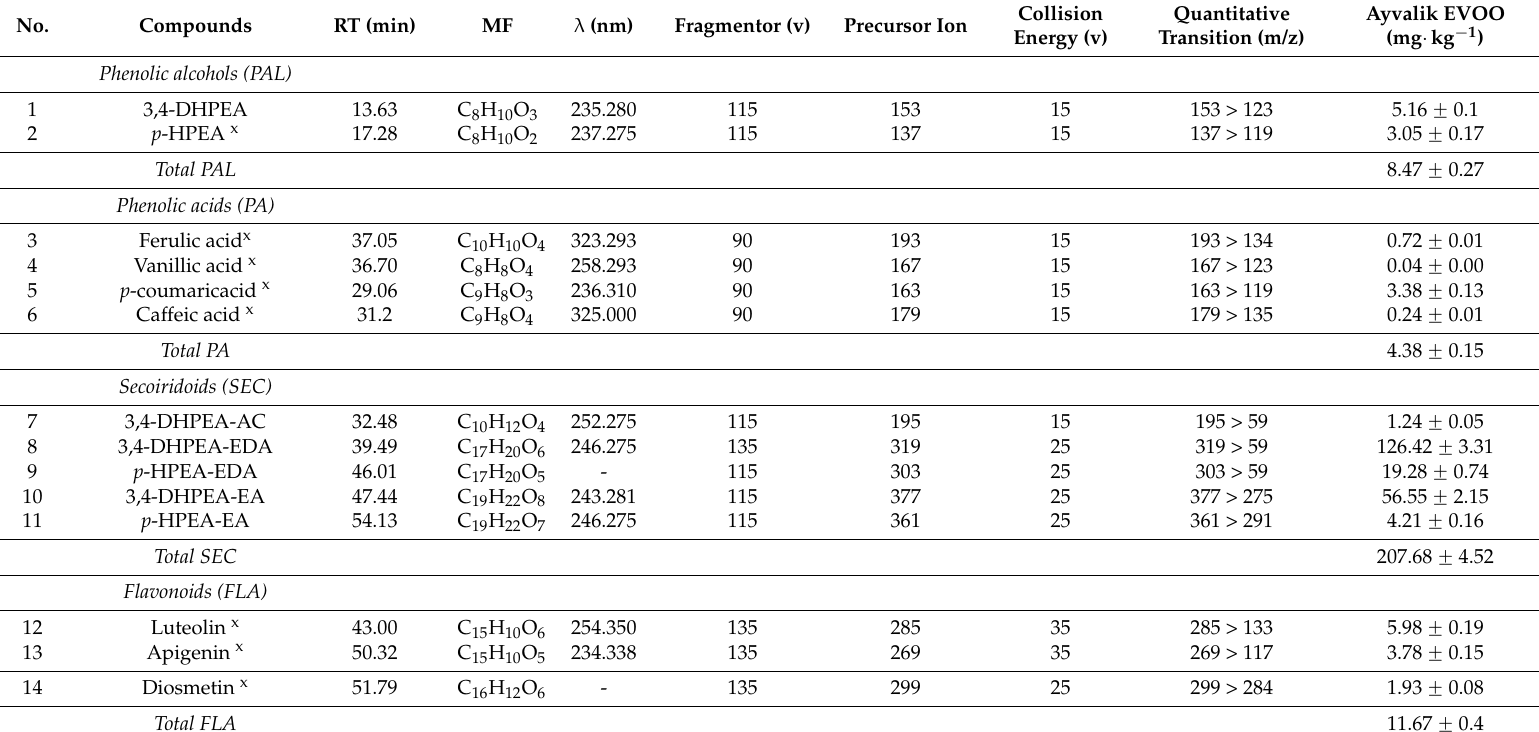
Table 4. Main phenolic compounds identified in olive oil extract by HPLC-DAD-ESI-MS/MS including: retention time (RT), molecular formula (MF), λ max , LC-MS/MS parameters and MRM